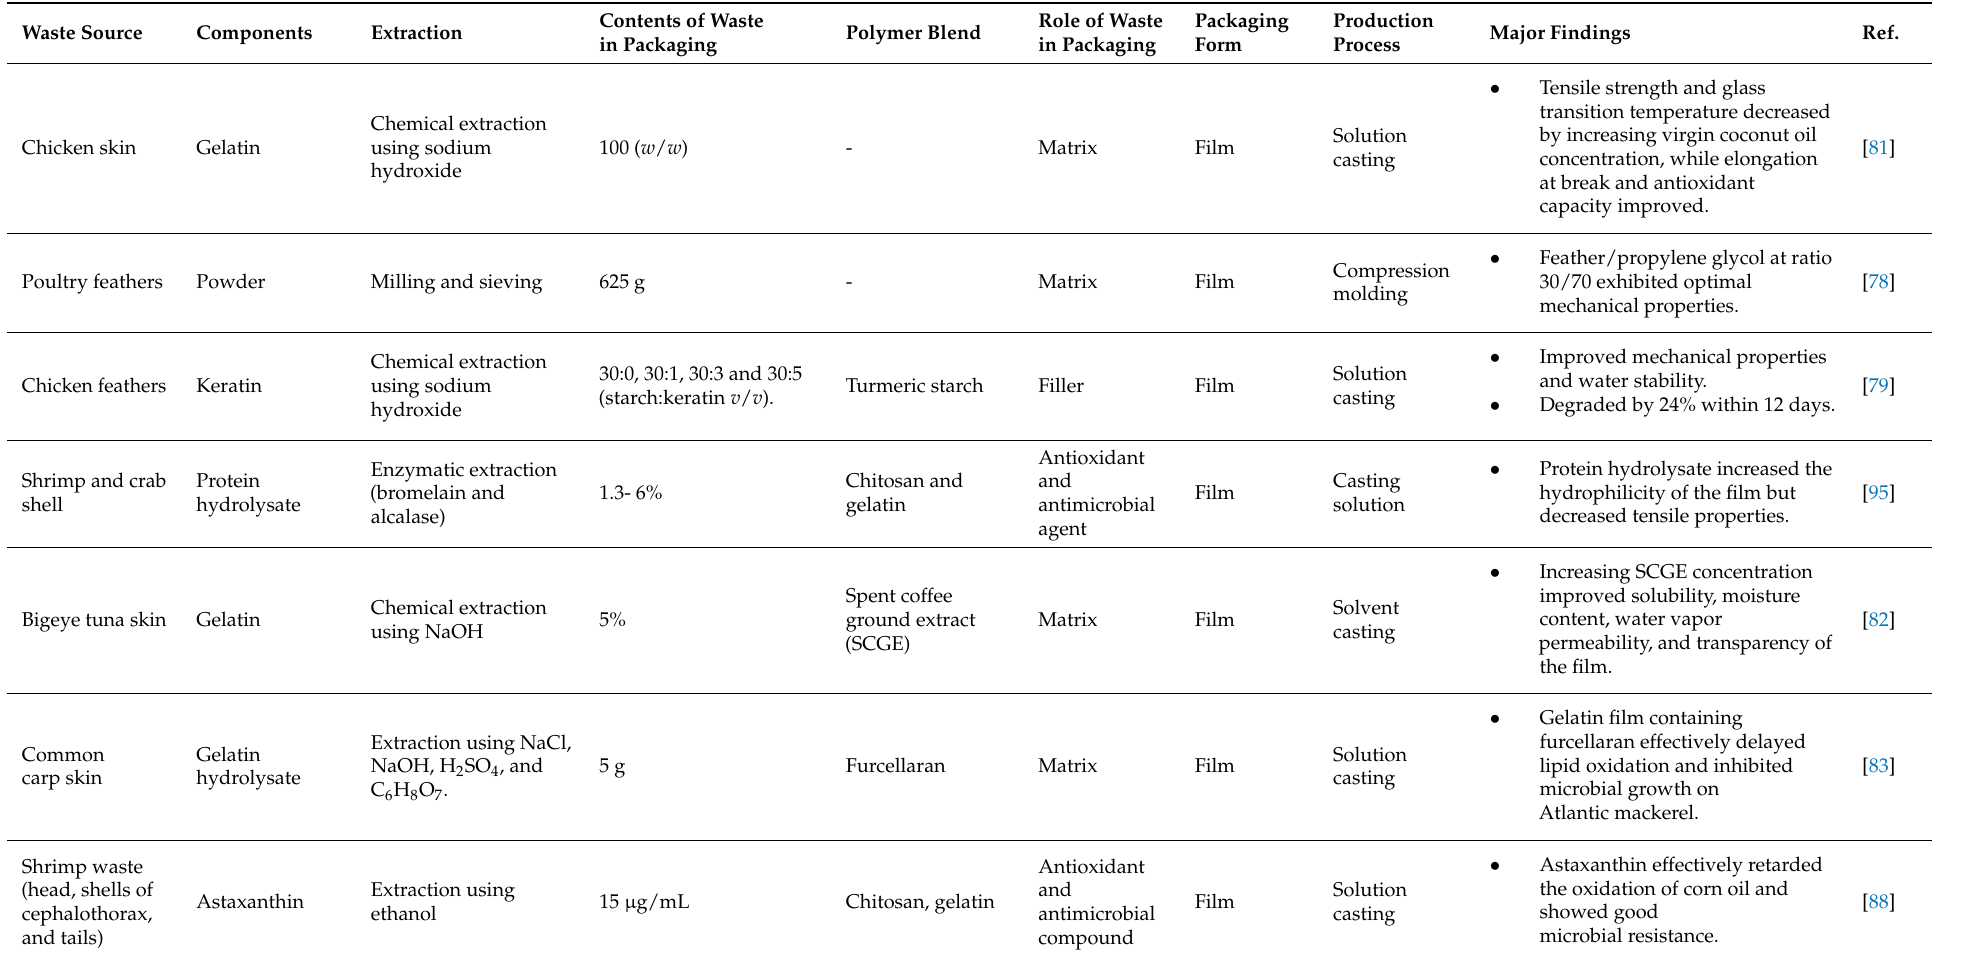
Table 4. Packaging developments utilizing animal waste